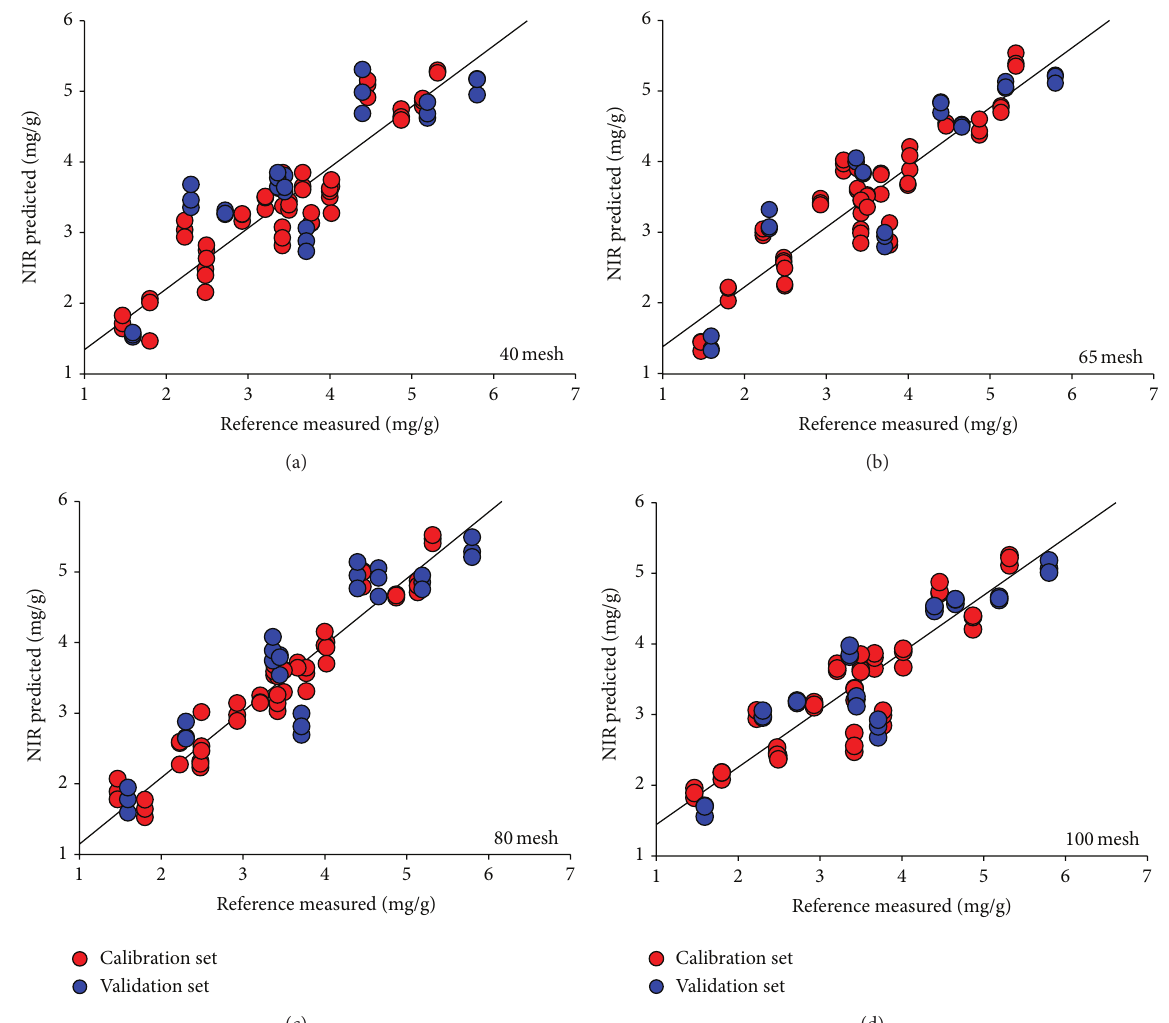
Figure 4: Correlation diagrams between the NIR predicted values and the reference values of SSA content.